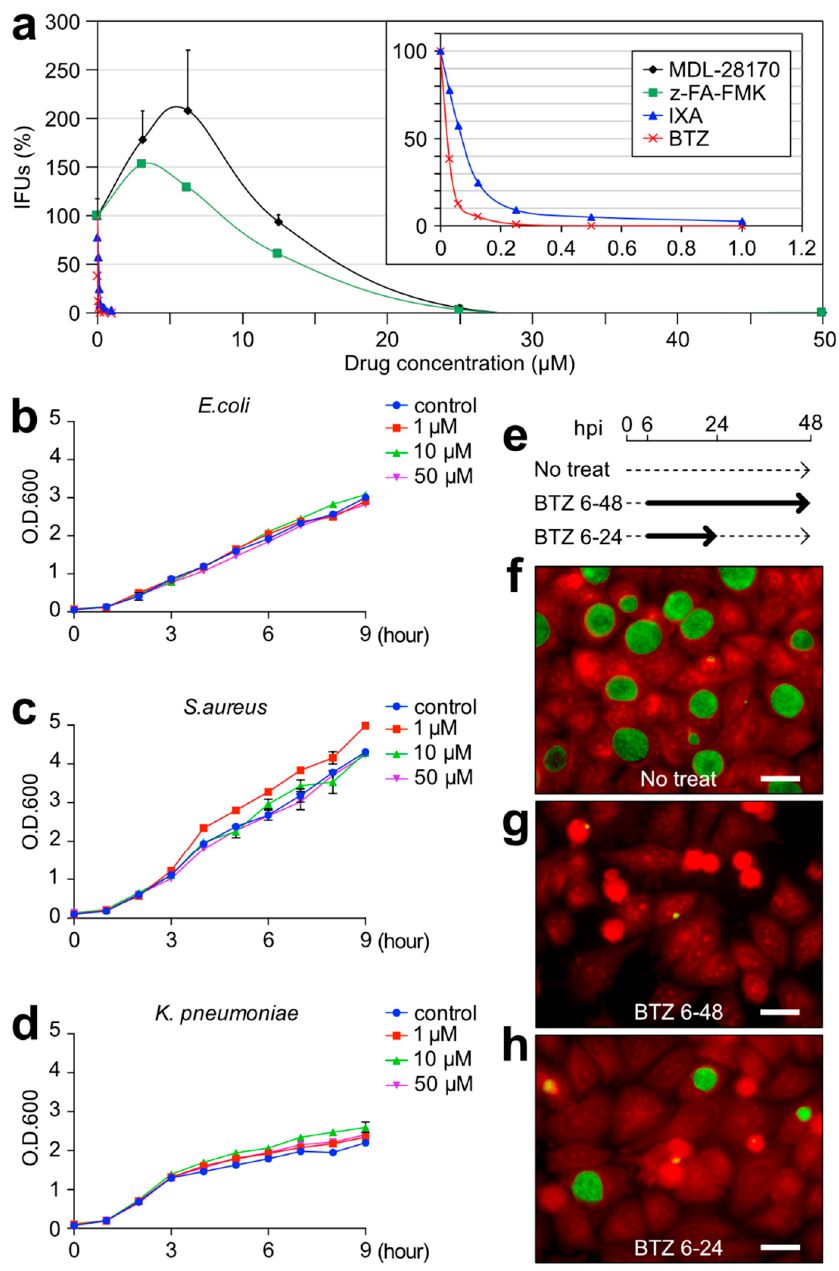
Figure 3. BTZ specifically showed an intense bacteriostatic effect against Chlamydia . ( a ) Growth inhibition activity of the indicated four compounds against C. trachomatis L2. The infected cells were separately treated with compounds at six- or seven-point concentrations for 48 h, and after, the IFU scores were verified. The inset represents the expansion of the graph from 0 to 1.2 μ M. Data are the mean ± SD of three independent wells. ( b – d ) Overnight culture of E. coli ( b ), S. aureus ( c ), and K. pneumoniae ( d ) adjusted the turbidity of the optical density at 600 nm (OD600) = 0.1 by diluting it with fresh medium and then culturing it for 9 h with or without BTZ at the indicated concentrations. The turbidity of OD600 nm of each culture was measured. Data are the mean ± SD of three independent cultures. ( e ) Schematic time course of the 1 μ M BTZ treatment and removal for C. trachomatis -infected cells. Solid arrows denote the treatment period, while dashed arrows denote the culture period without, or removal of, an inhibitor. ( f – h ) The infected cells were fixed at 48 hpi and stained as described in Figure 1. A red stain denotes Evans blue counterstaining. Scale bar, 20 μ m.